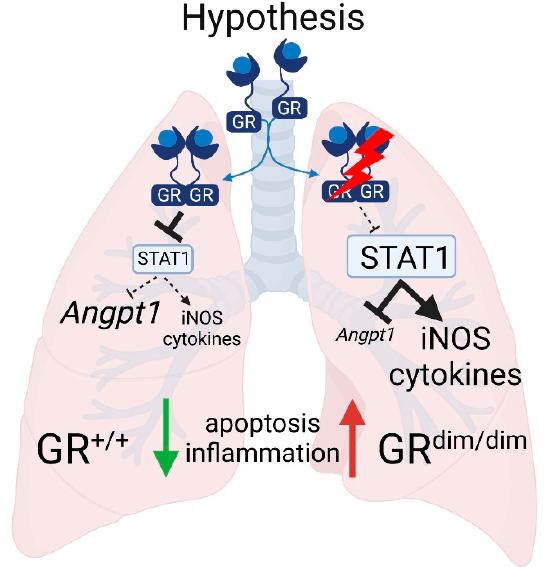
Figure 5. In resuscitated HS, the GC bound GR dimer may impact lung injury via repression of STAT1-dependent expression of the pro-inflammatory iNOS and enhanced expression of the lung-protective Angpt1 . The figure was created with biorender.com (accessed on 23 December 2021).